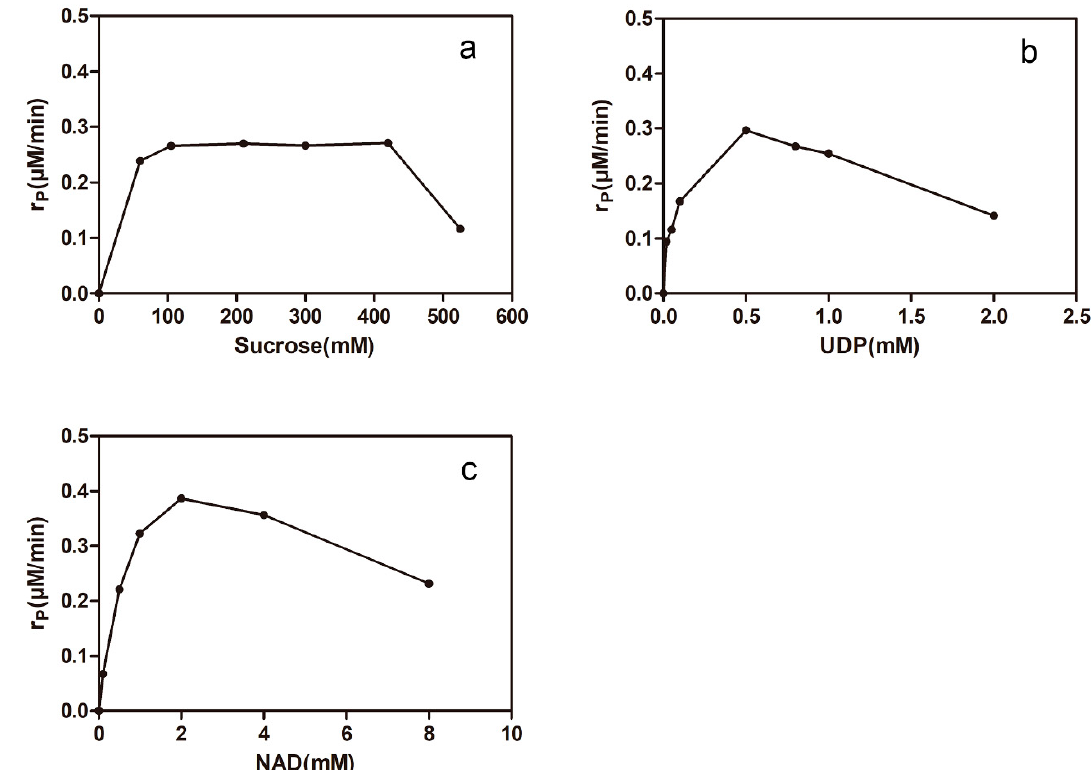
Figure 7. Isorhamnetin-3- O -rhamnoside production rate (r p ) by synergistic catalysis as a function of ( a ) sucrose, ( b ) UDP, and ( c ) NAD + concentrations. Values shown are the mean of duplicate experiments, and the variation about the mean was below 5%.